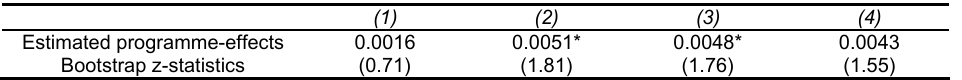
Table 5: Programme effect calculated with matching on residuals obtained from DiD OLS